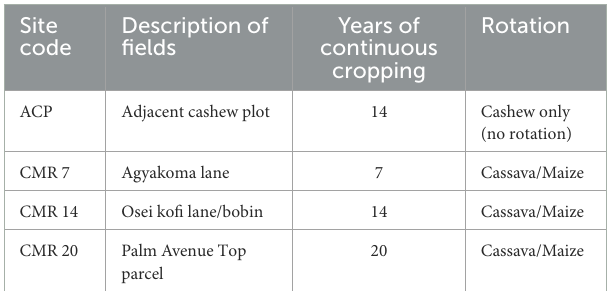
TABLE 1 General description of the understudied